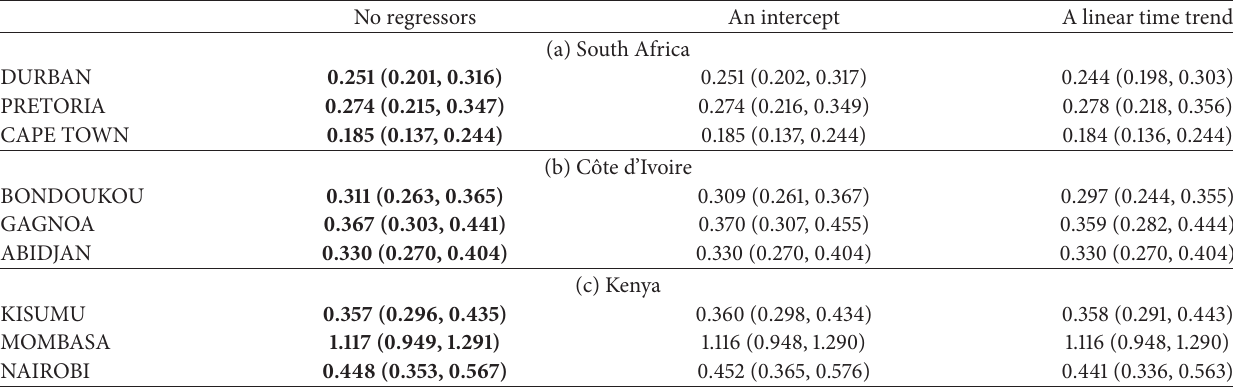
Table 4: Estimates of 𝑑 in the deseasonalized monthly data using a long memory model with white noise disturbances. No regressors